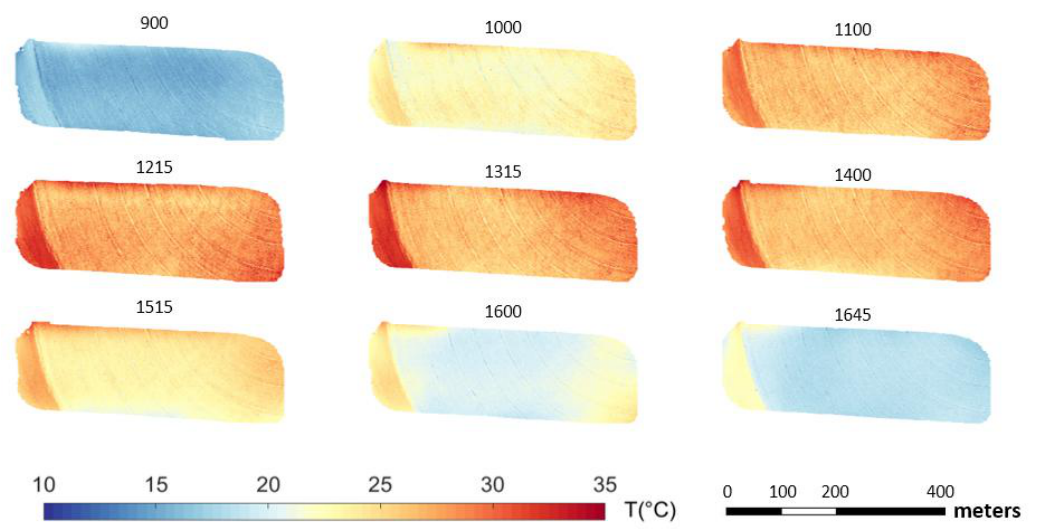
Figure 7. Maps of the UAV-based LST between 0900 and 1645 on 31 January